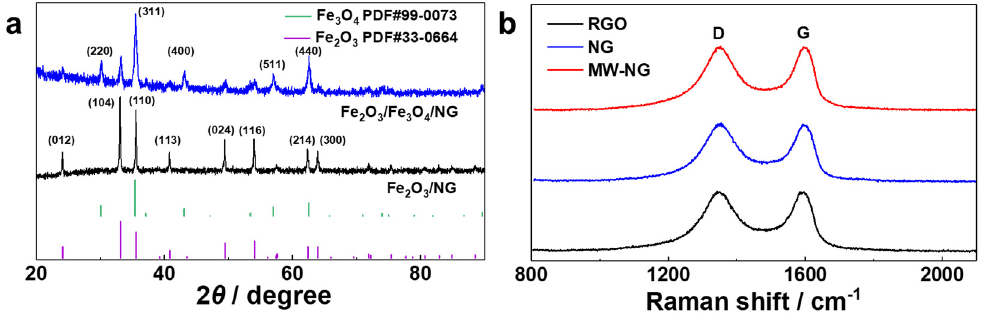
Figure 2. ( a ) XRD patterns of Fe 2 O 3 / Fe 3 O 4 / NG and Fe 2 O 3 / NG composites. ( b ) Raman spectra of